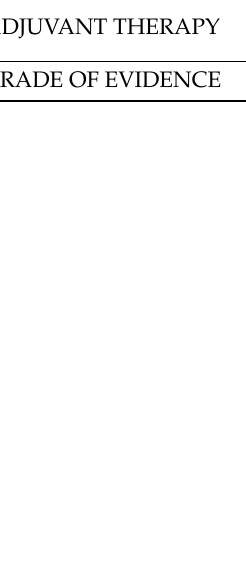
Table 2. Recommendations and grade of evidence on adjuvant therapy for pulmonary carcinoid (TC and AC) from: National Comprehensive Cancer Network (NCCN; North American Neuroendocrine Tumor Society (NANETS); European Society of Medical Oncology (ESMO); European Neuroendocrine Tumor Society (ENETS) [5,8–10]. NCCN NANETS ESMO ENETS